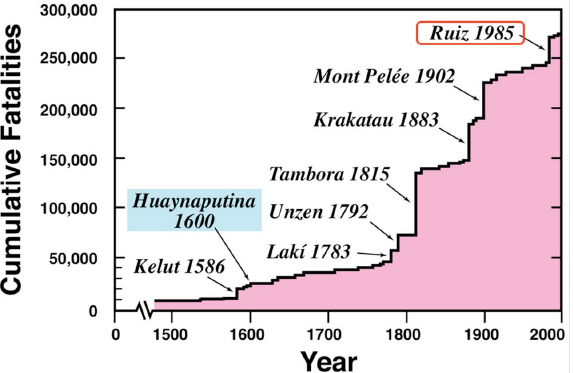
Fig. 11. Plot of the cumulative fatalities from volcanic eruptions worldwide during the period 1500 – 2000. Some of the worst historical volcanic disasters are identified; note the relatively small number fatalities for the huge 1600 Huaynaputina eruption compared with that for the much smaller eruption 1985 Ruiz eruption (see text). [Data sources: Tilling, 1989; Simkin and Siebert, 1994; Tanguy and others, 1998.]